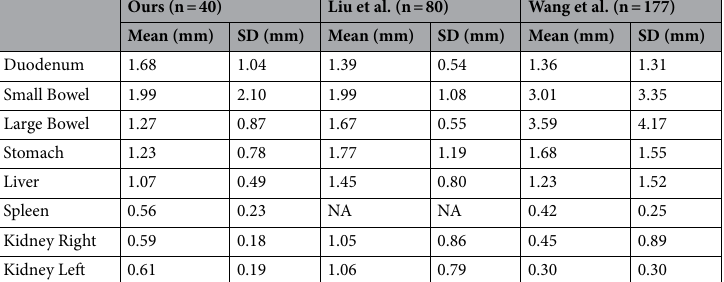
Table 5. Mean surface distance comparisons between our tool and other state-of-the-art upper-abdominal auto-segmentation models.